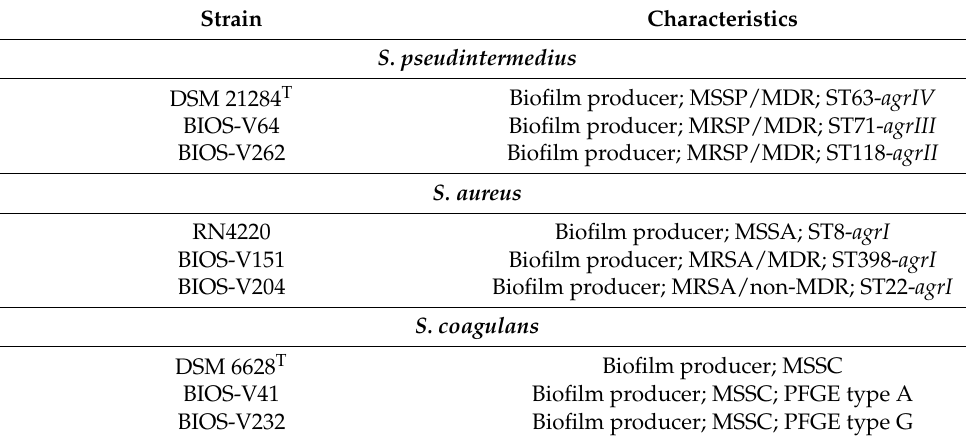
Table 3. Main characteristics of the biofilm-producing strains studied on the G. mellonella infection assays